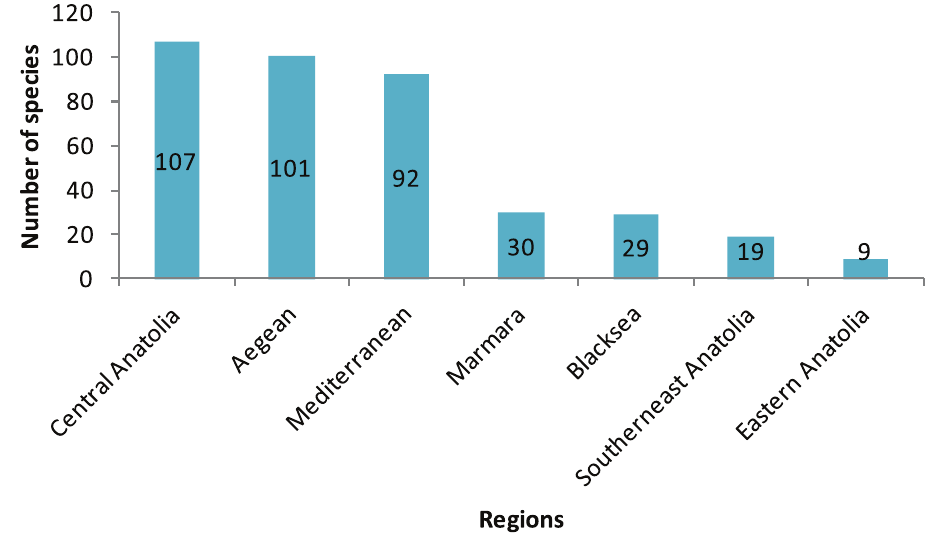
Figure 1. The number of the species according to geographical